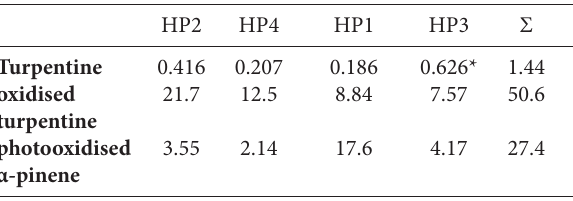
Table 1. Concentrations of α-pinene hydroperoxides in turpentine before and after 20 days of air-exposure compared to concentrations of hydroperoxides synthesised photochemically with singlet oxygen (data in